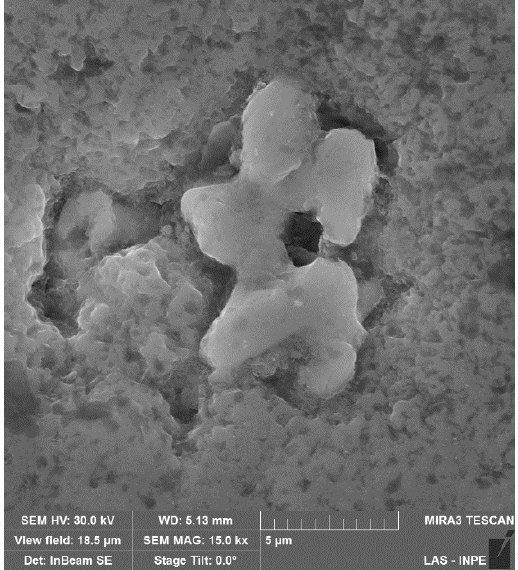
Figure 4. SEM–FEG micrograph of VC coating exposed to palm biodiesel at 1320